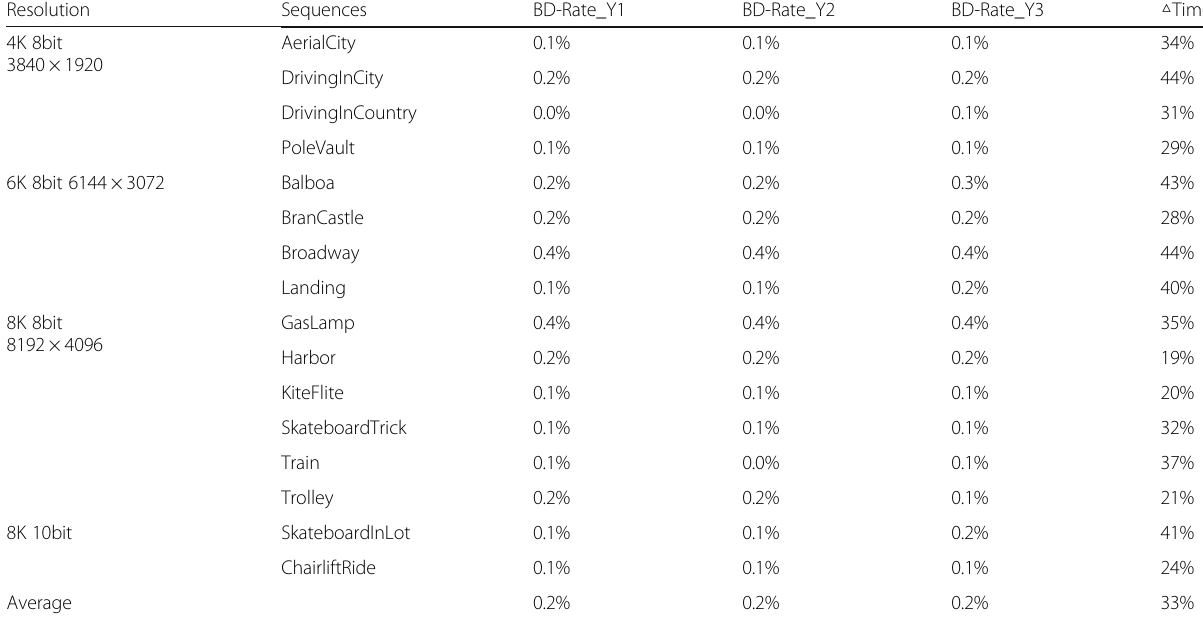
Table 5 Performance comparison between the original HM 16.16 and the proposed algorithms Resolution